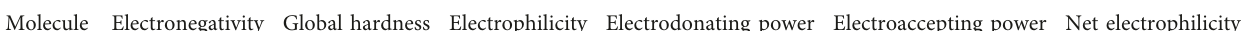
Table 10: Global reactivity descriptors (in eV) for the siphonaxanthin pigment calculated with the MN12SX and N12SX density functionals and the Def2TZVP basis set using the four solvents, simulated with the SMD parametrization of the IEF-PCM model. MN12SX